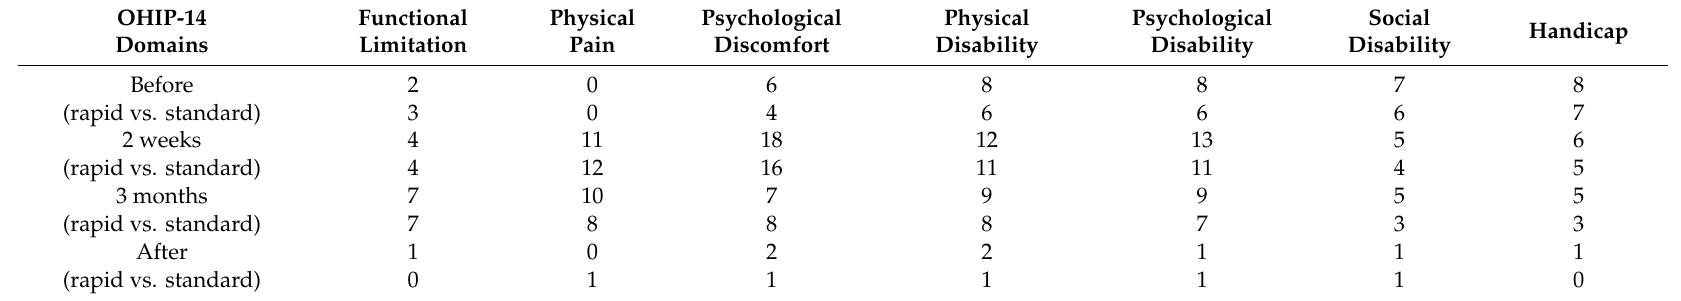
Table 6. The number of patients with impaired domains in cancer survivors with rapid and standard duration of orthodontic